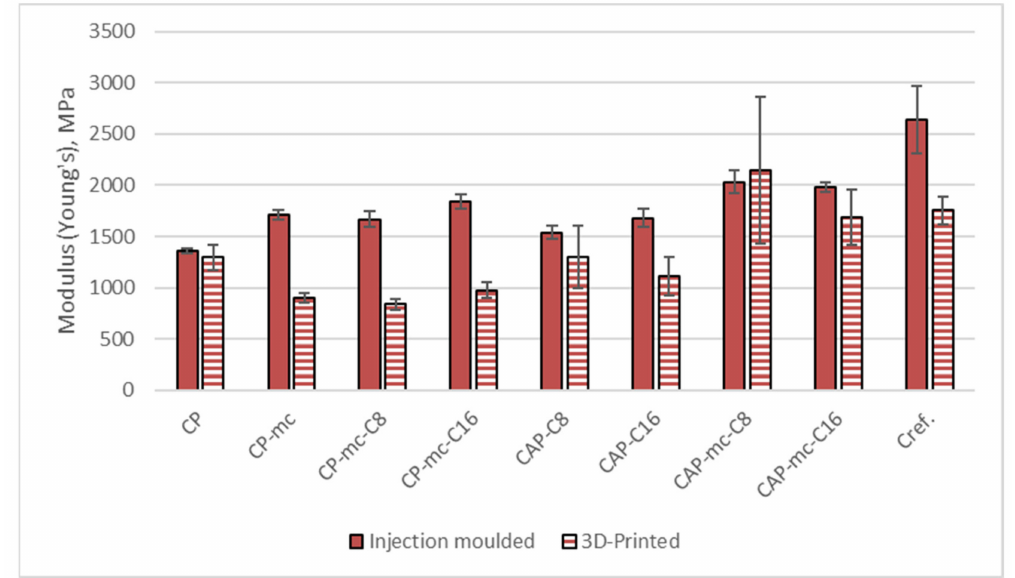
Figure 8. Young’s modulus for injection molded and 3D printed materials. CP is commercial cellulose acetate propionate with 13% commercial plasticizer; CP-mc is 20% microcellulose containing CP; CP-mc-C8 contains also 4% cellulose octanoate C8; CP-mc-C16 contains 4% of cellulose palmitate C16; CAP-C8 contains neat cellulose acetate propionate (CAP) with 17% C8; CAP-C16 contain 17% C16 in CAP; CAP-mc-C8 contains 20% mc and 17% C8 in CAP; CAP-mc-C16 contains 20% mc and 17% C16 in CAP and Cref is PLA-based material with 20% cellulose